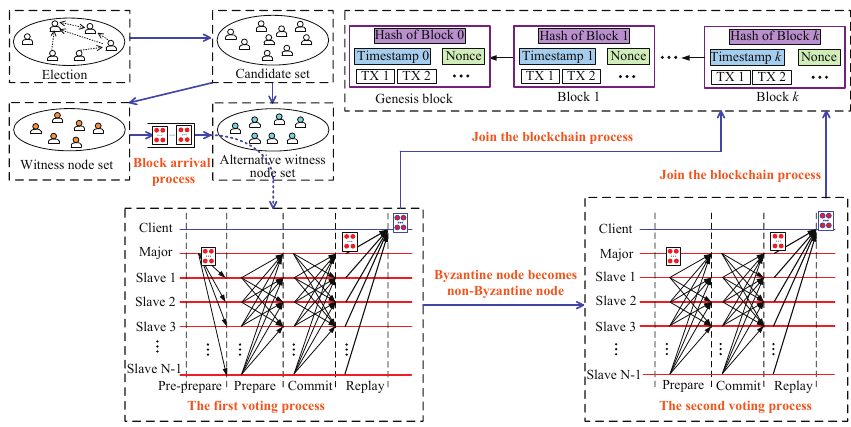
Figure 1. Blockchain queuing system based on the block consensus